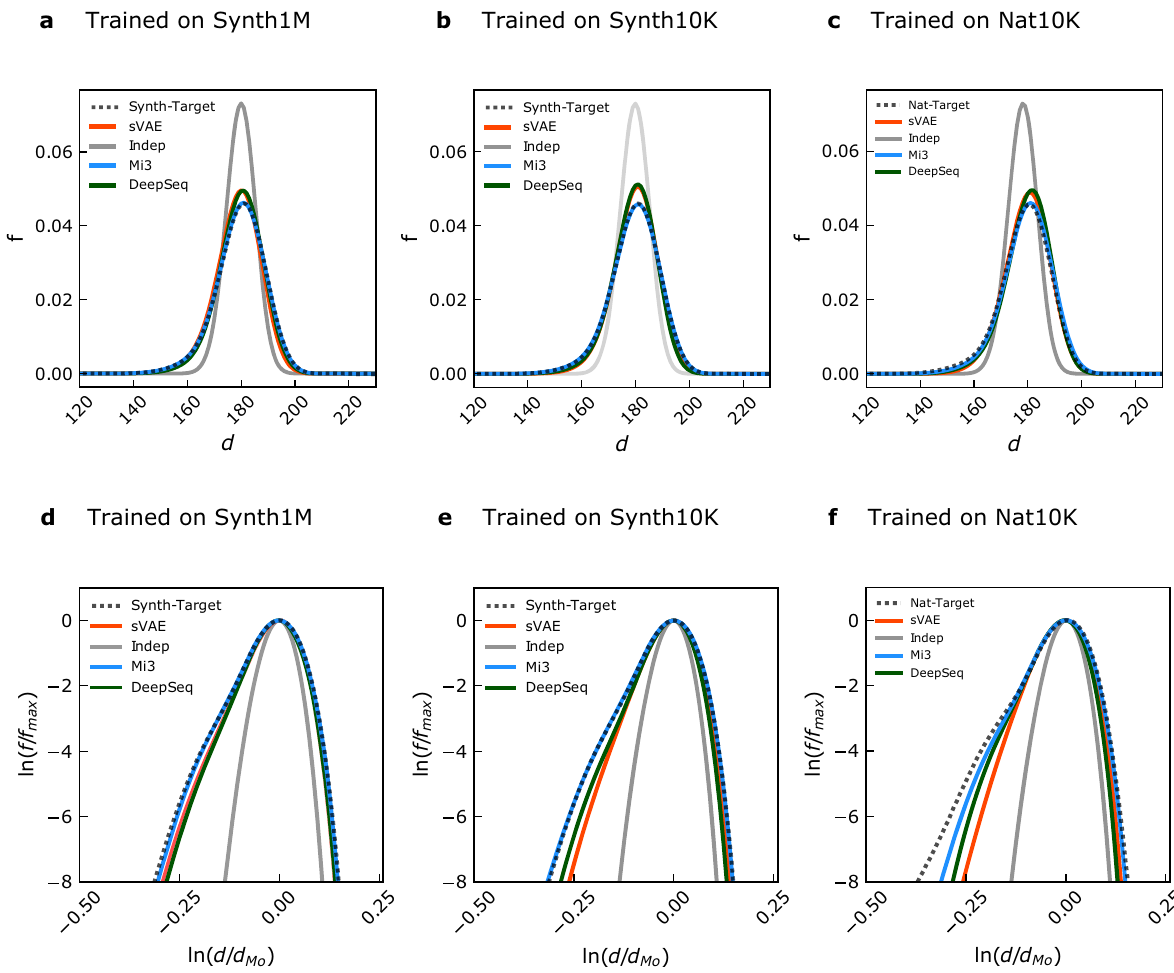
Fig. 4 Ability of GPSMs to capture Hamming distance distribution. These plots illustrate whether sequences generated from the GPSMs reproduce the overall sequence diversity of their respective targets. Mi3 (blue), DeepSequence (green), sVAE (orange), and Indep (gray) distributions are compared to target probability distribution (dotted black). GPSMs were trained on 1M synthetic (Synth1M, a , d ), 10K synthetic (Synth10K, b , e ), or 10 K natural (Nat10K, c , f ) sequences from the corresponding target probability distribution. All Hamming distributions were computed from 50K-sequence MSAs, except for the natural target, which was computed from a 10K-sequence target MSA due to data limitations (see Supplementary Note 12). Top row: Hamming distances d ( x -axis) are shown about the mode, and frequency f is normalized as a fraction of total ( y -axis). Mi3 perfectly matches the target probability distribution from a to c , whereas DeepSequence and sVAE overlap each other and share a mode with a slightly higher frequency than the target and Mi3. Indep has a slightly lower mode than all the other GPSMs, and a much higher mode frequency. Because generative capacity for all GPSMs is unchanged from a to c , none of them are sensitive to training or evaluation sample size for this metric. Bottom row: Re-scaled logarithmic Hamming distance distributions better discriminate between GPSMs with respect to generative capacity than the normal Hamming distance distribution. Before being log-scaled, the Hamming distances d are normalized by the mode d Mo ( x -axis), and frequencies f are normalized by the maximum Hamming distance f max ( y -axis). This transformation highlights minute differences between distributions at low frequencies in the tails of the distributions on the left-hand and right-hand